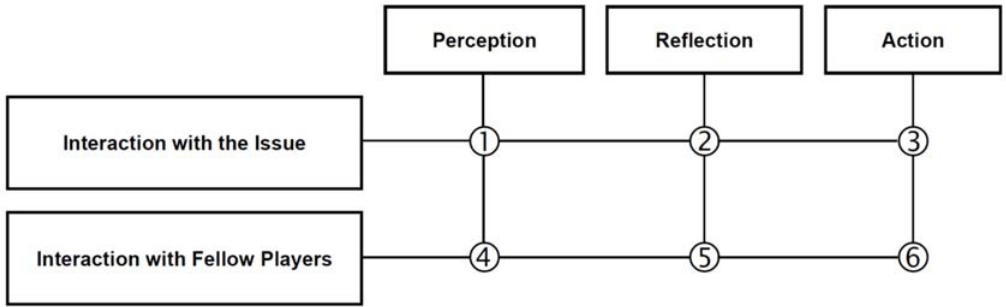
Figure 2. Dimensions of artistic behaviour during Art Hacking.